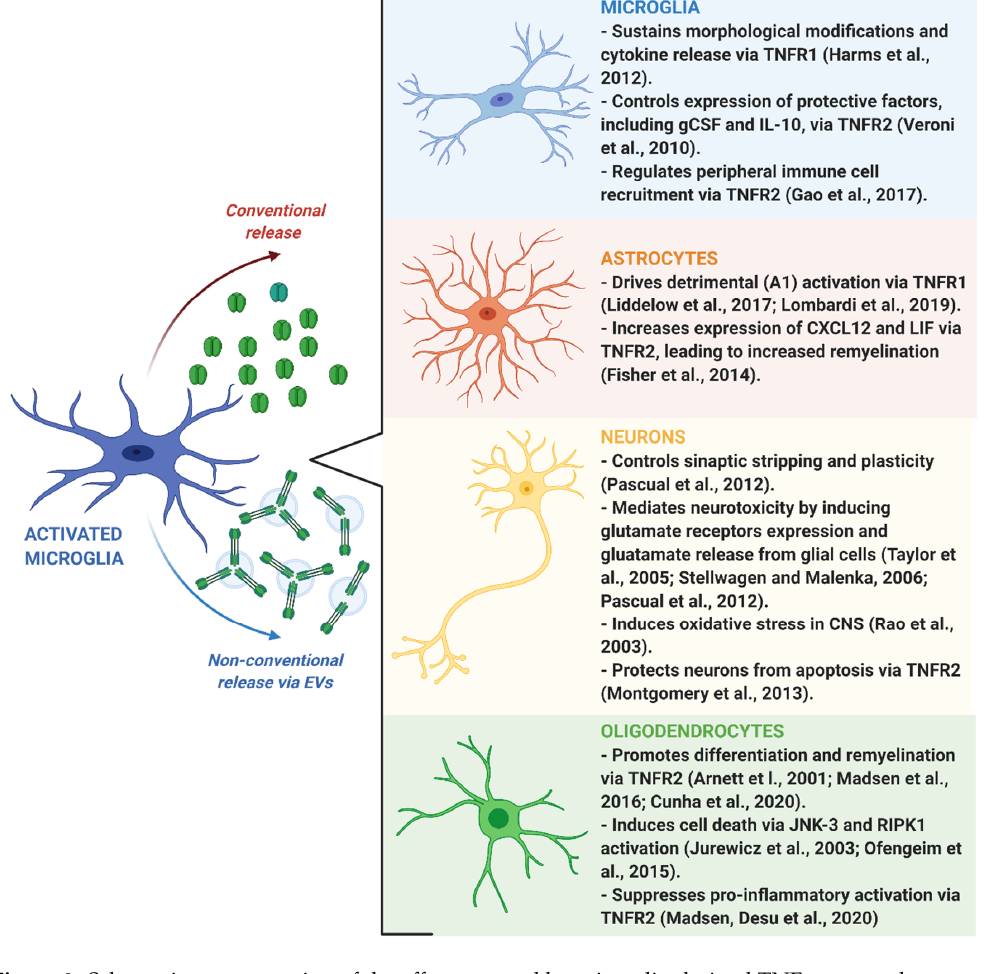
Figure 2. Schematic representation of the effects exerted by microglia-derived TNF on central nervous system (CNS) cells. Activated microglia is able to release TNF via conventional or extracellular vesicle (EV)-mediated non-conventional pathways. Once released, TNF induces specific detrimental or beneficial responses in recipient cells, including microglia, astrocytes, neurons and oligodendrocytes (right panels), through activation of TNFR1 and TNFR2 receptors. Created with BioRender.com.